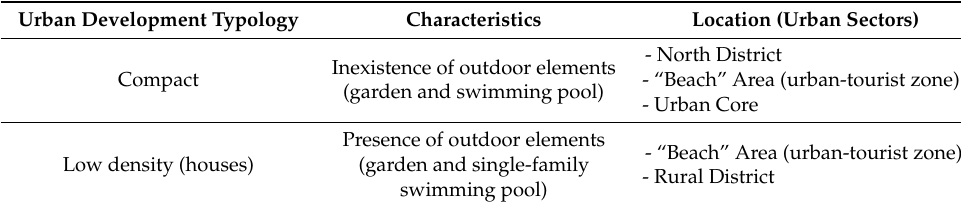
Table 1. Characteristics and location of the urban development typologies